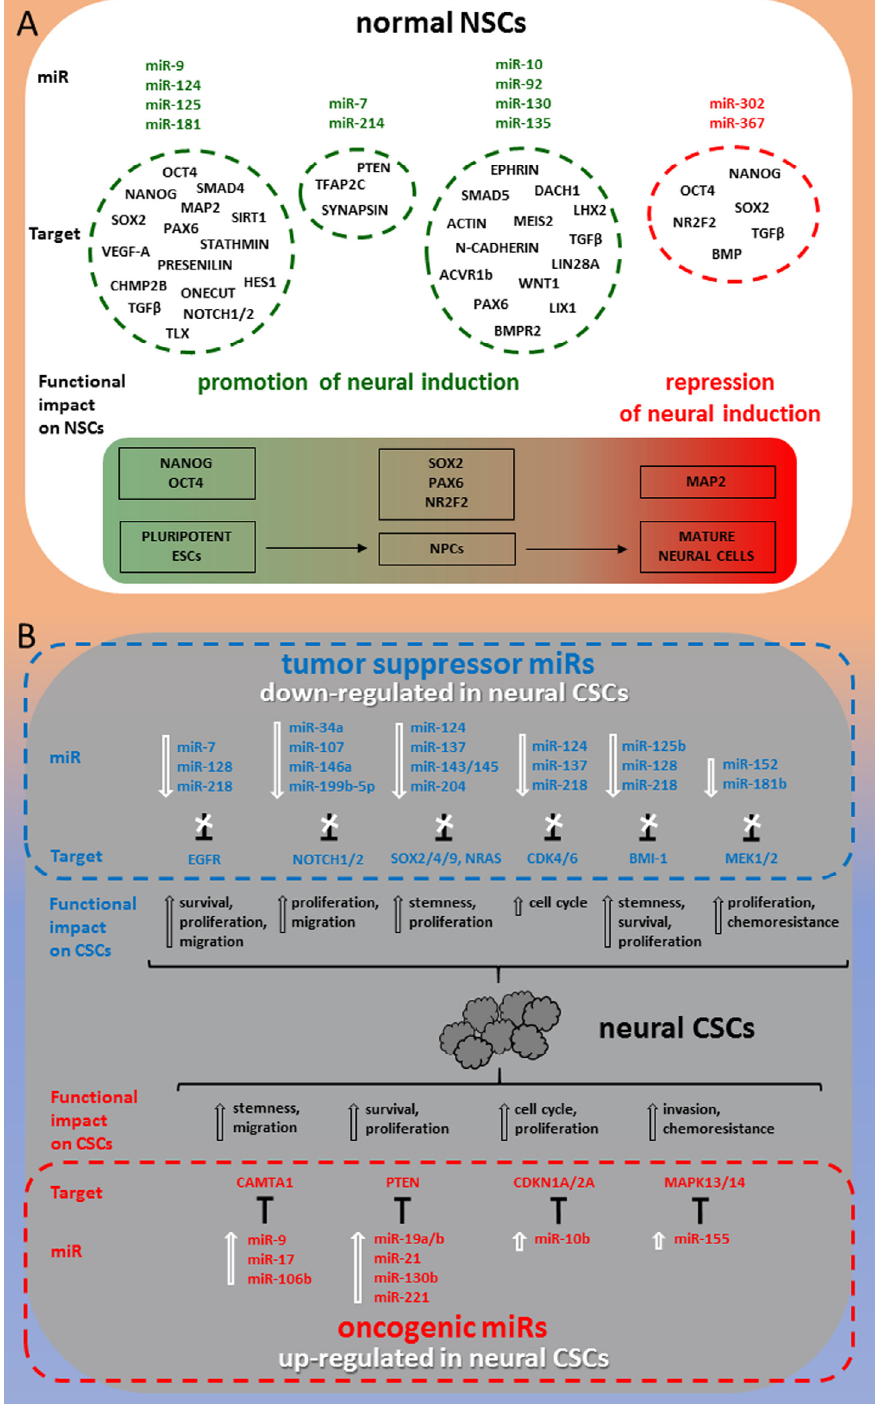
Figure 1. miRNA-target regulatory network in neural stem cells (NSCs). In normal NSCs, miRNAs are intercalated from embryonic stages along the differentiation pathway toward mature neural lineages ( A ). In neural cancer stem cells (CSCs), miRNAs operate as either tumor suppressors or oncomiRs governing the maintenance of CSCs and the homeostasis of neuronal/glial tumors ( B ).